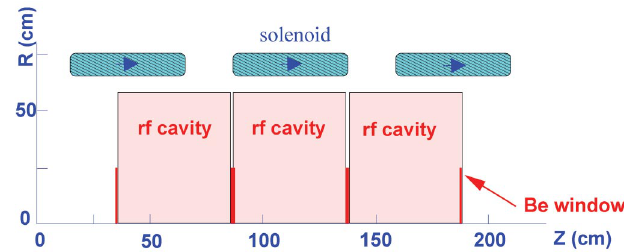
FIG. 11. (Color) Longitudinal phase space after the phase rota- tion